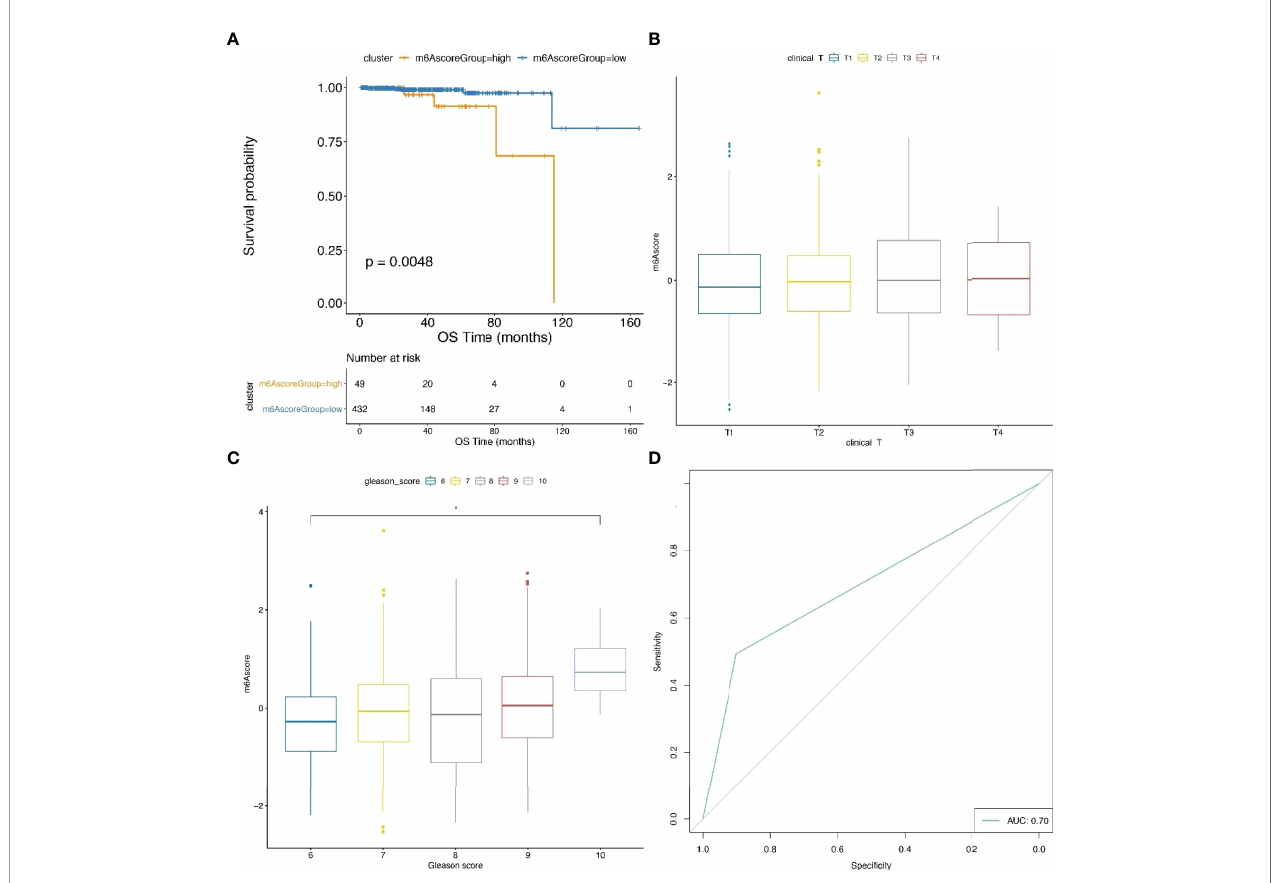
FIGURE 8 | Comparison analysis and validation of m6Ascore model. (A) Survival analysis plot indicates a signi fi cant difference between TCGA samples with high and low m6A score. (B, C) The distribution of m6A score within distinct T stages and GLEASON_SCORE subgroups using TCGA data. (D) ROC curves for the prediction of metastatic and nonmetastatic prostate cancer between groups with high and low m6A